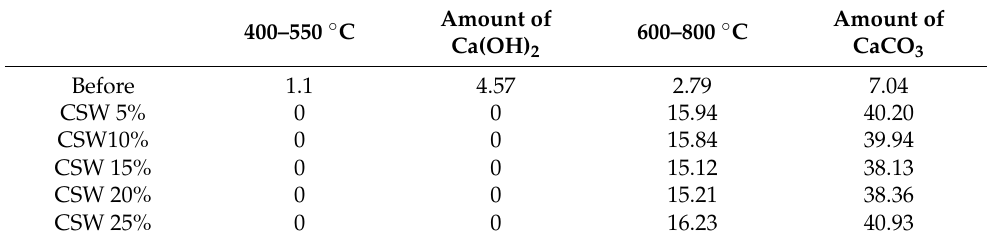
Table 4. Amounts of Ca(OH) 2 and CaCO 3 before and after supercritical CO 2